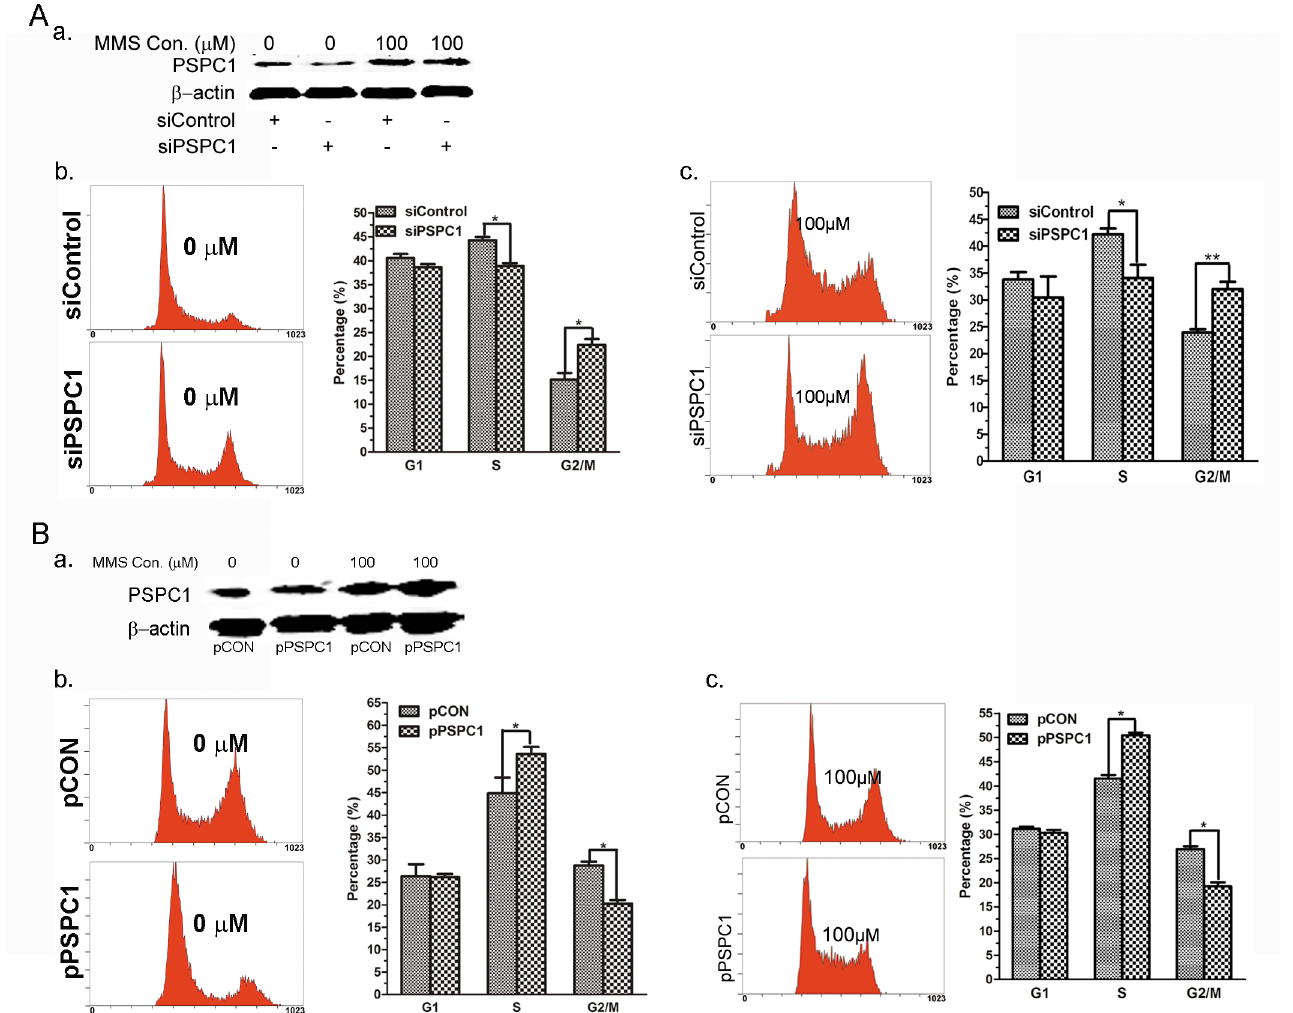
Fig 3. Modulation of PSPC1 influences MMS-induced cell cycle redistribution. (A) HeLa cells were transfected with siPSPC1 or siControl for 24 h, then treated with 0 μ M and 100 μ M of MMS for 12 h. The expression of PSPC1 was examined by Western blot and cell cycle was analyzed by flow cytometry. (B) HeLa cells were transfected with pPSPC1 or pCON to overexpress PSPC1 for 24 h, then treated with 0 μ M and 100 μ M of MMS for 12 h. The expression of PSPC1 was examined by Western blot and cell cycle was analyzed by flow cytometry. The values represent averages of three independent experiments, mean ± SD. * p < 0.05, ** p < 0.01, as compared with the control